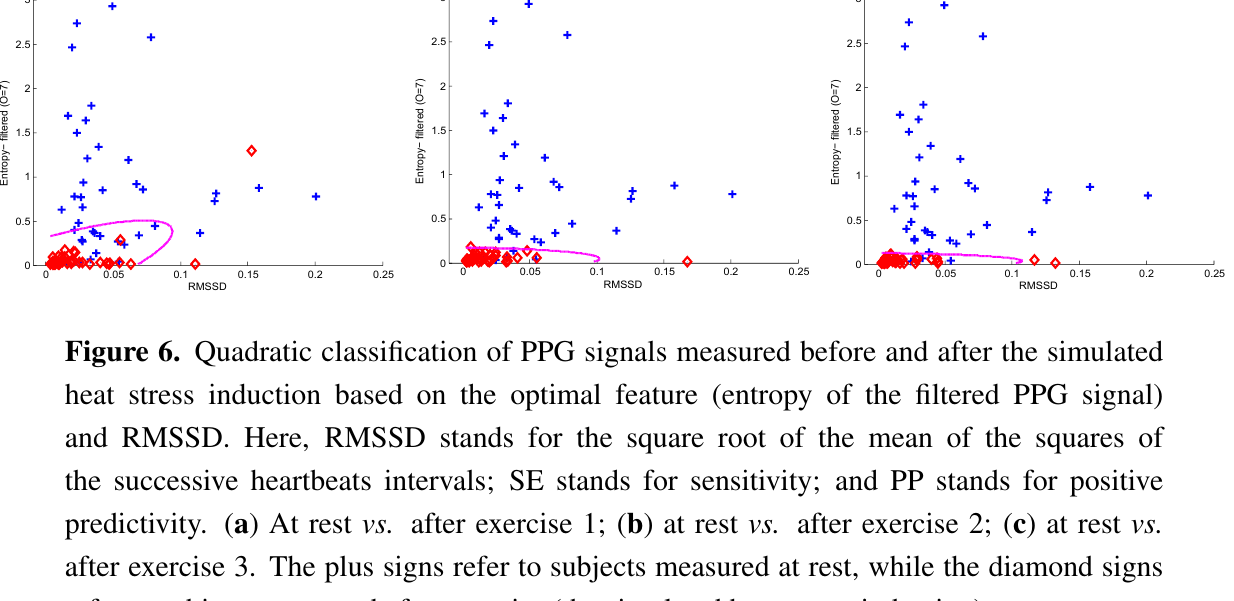
Figure 5. Quadratic classification of PPG signals measured before and after the simulated heat stress induction based on the RMSSD. Here, RMSSD stands for the square root of the mean of the squares of the successive heartbeats intervals; SE stands for sensitivity; and PP stands for positive predictivity. ( a ) At rest vs. after exercise 1; ( b ) at rest vs. after exercise 2; ( c ) at rest vs. after exercise 3. The plus signs refer to subjects measured at rest, while the diamond signs refer to subjects measured after exercise (the simulated heat stress induction).